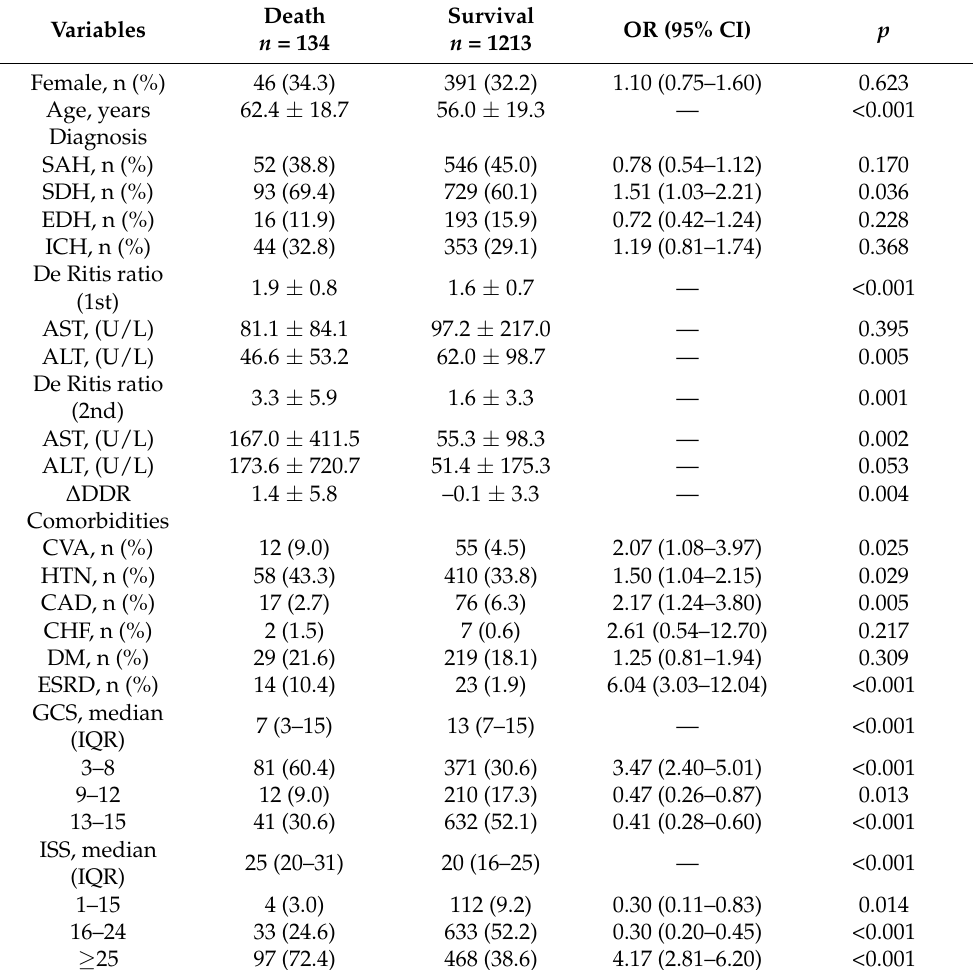
Table 1. Comparison of the injury and patient characteristics of death and survival patients in the study